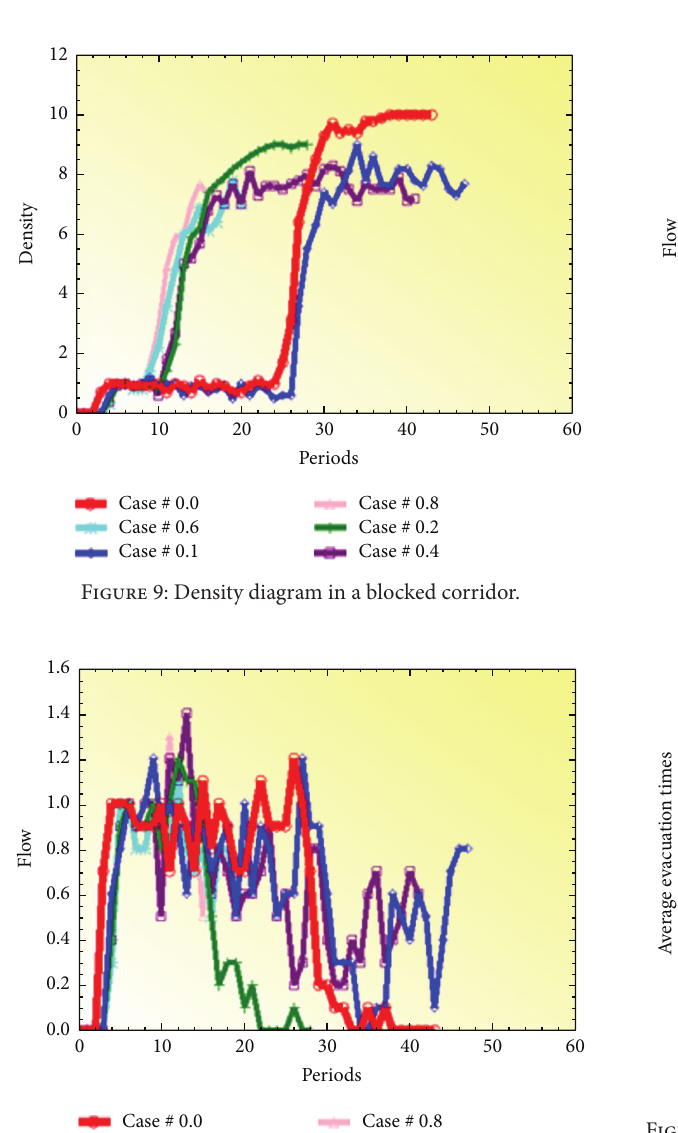
Figure 12: Pedestrians’ average evacuation time in a blocked